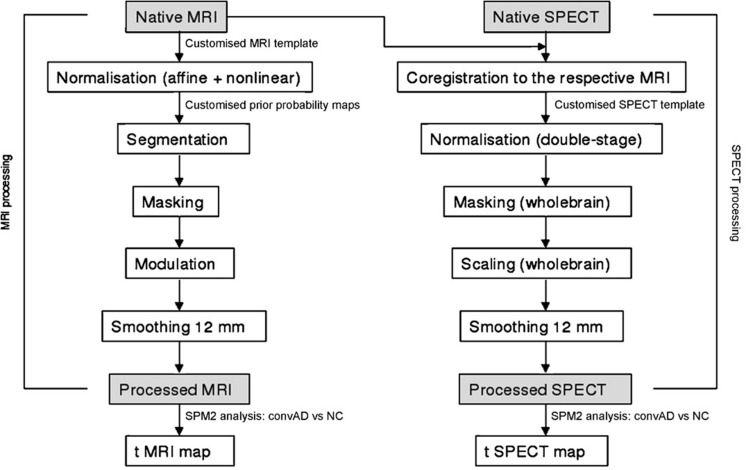
Flow chart summarizing the whole MRI-SPECT processing protocol.